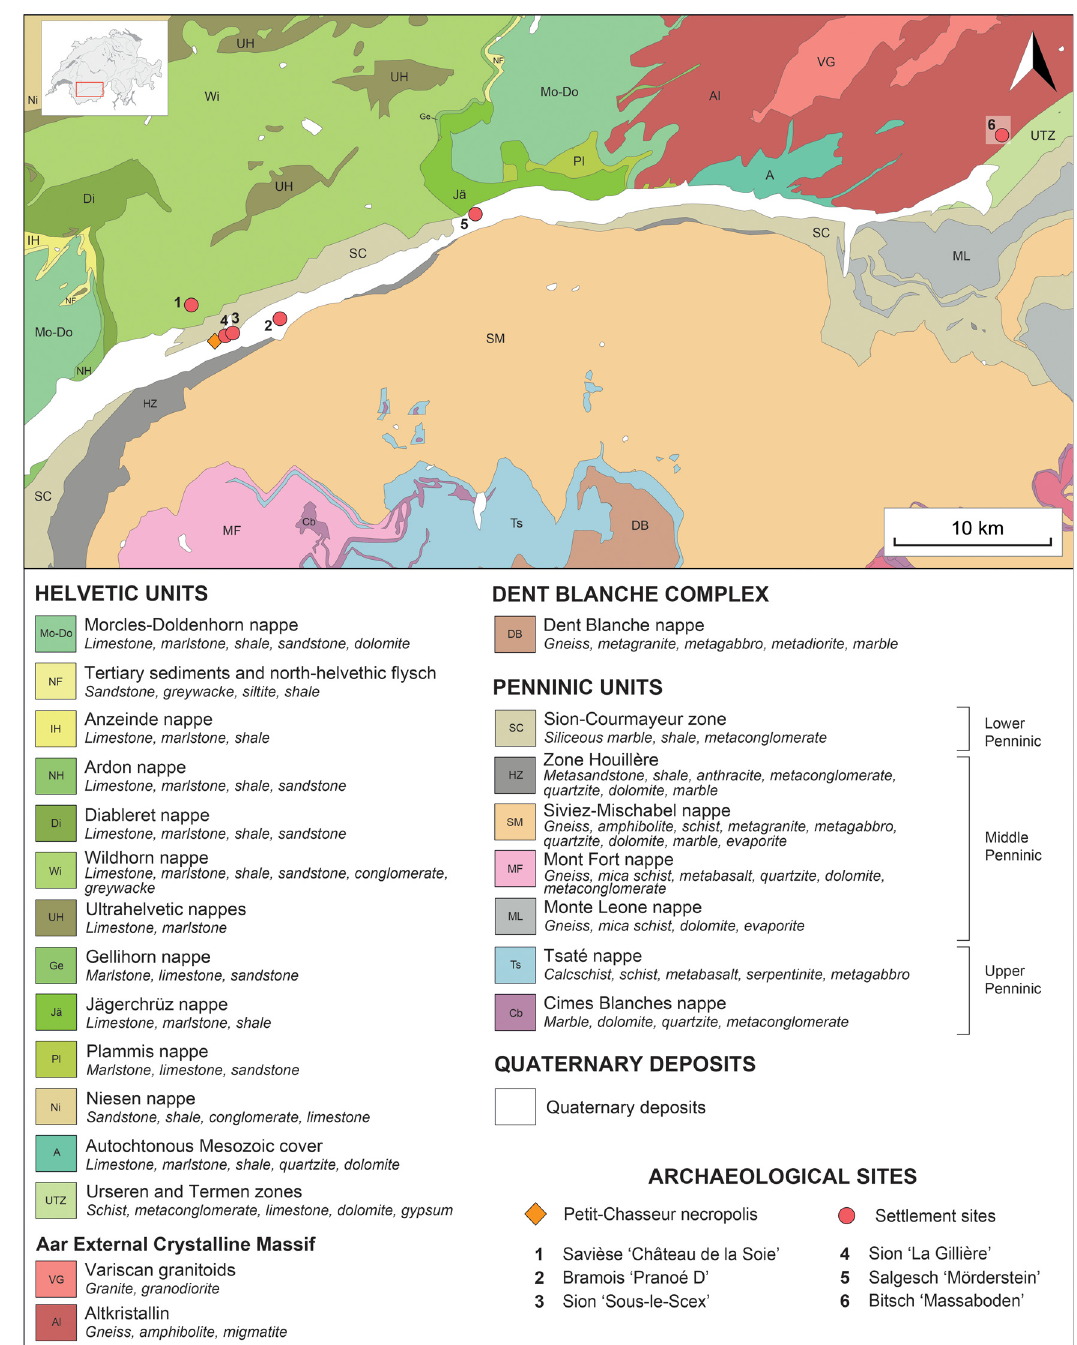
Figure 3: Litho - tectonic map of the study area with the main lithology outcropping in each nappe. Modi fi ed after the data provided by the Swiss Federal O ffi ce of Topography ( https://map.geo.admin.ch/ )